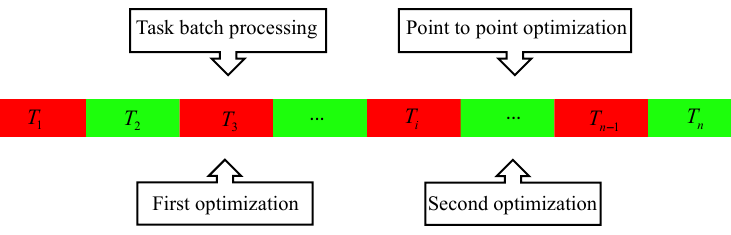
Figure 8. Batch optimization and point-to-point optimization work